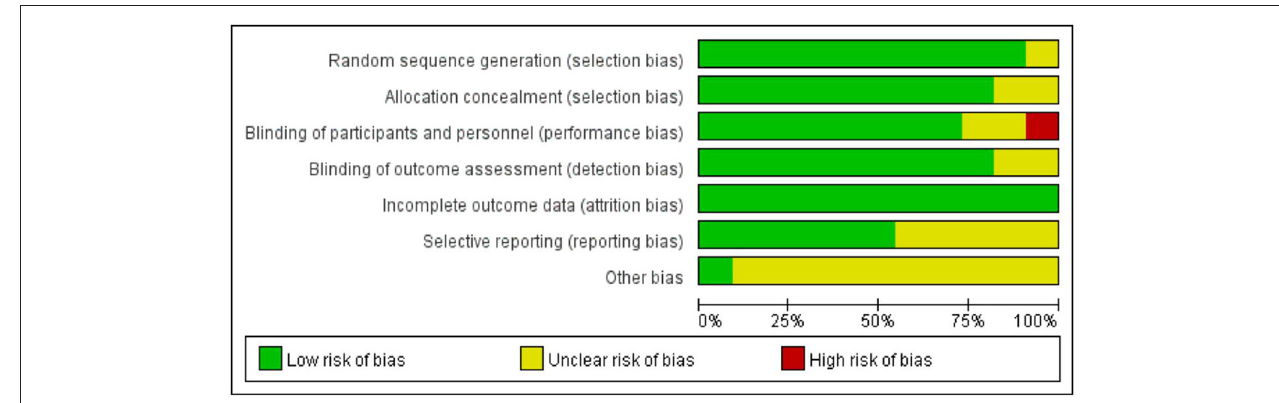
FIGURE 2 | Demonstrate the risk of bias in the included